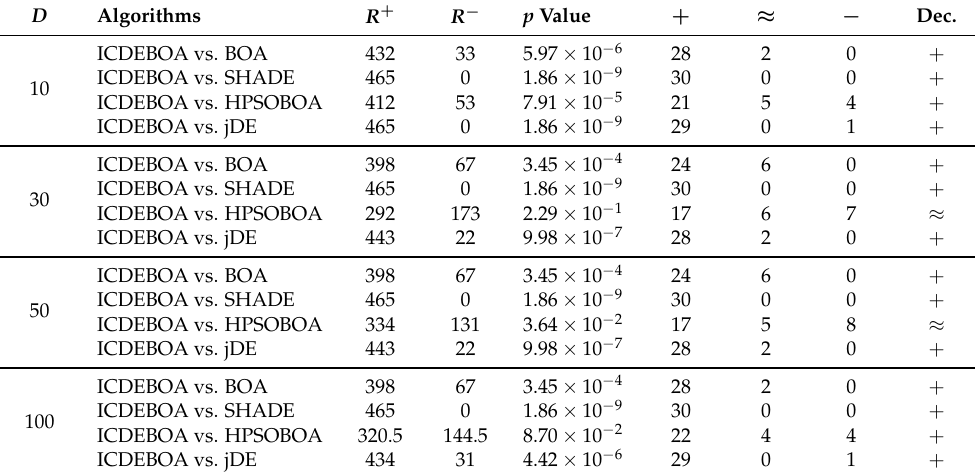
Table 3. The results of performing Wilcoxon test on CEC2014 objective functions for all consid- ered